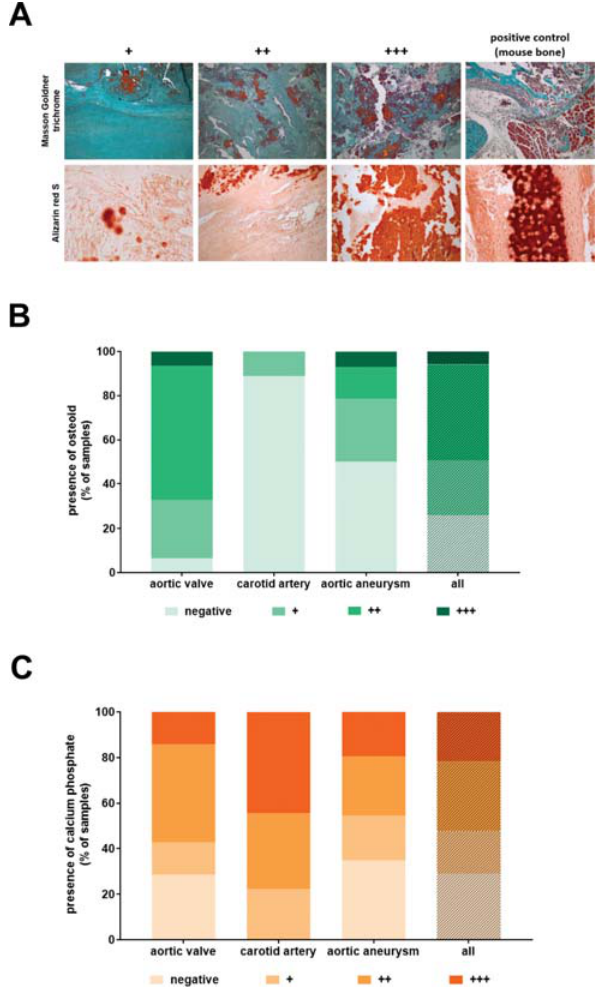
Table 1 Frequency of calci fi cation in areas with